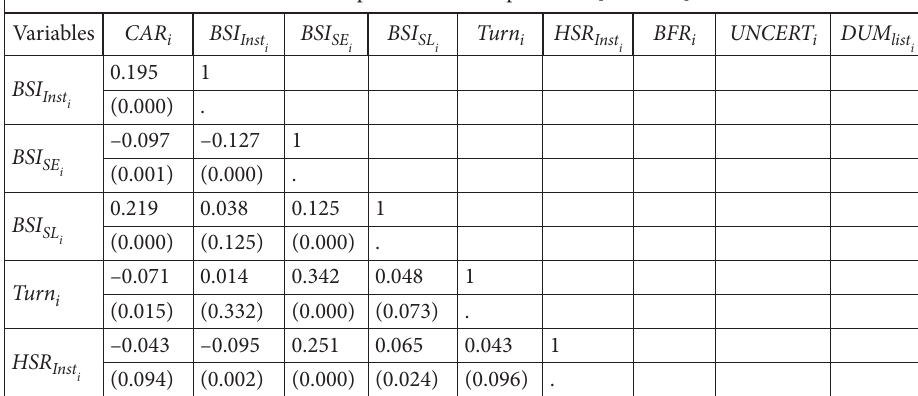
Table 2. Correlations